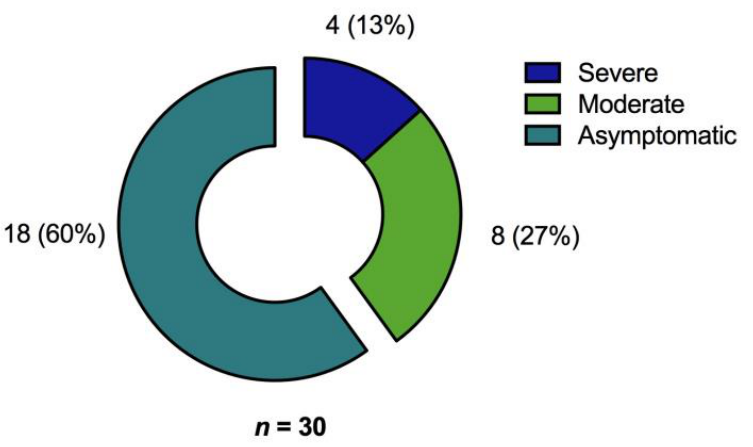
Figure 3. Proportion of convalescent patients with no detectable SARS-CoV-2 reactive T cells as determined by ELISpot analysis ( n = 30) after stimulation with the various S-peptide pools with regard to primary COVID-19 severity [ n (%)] .